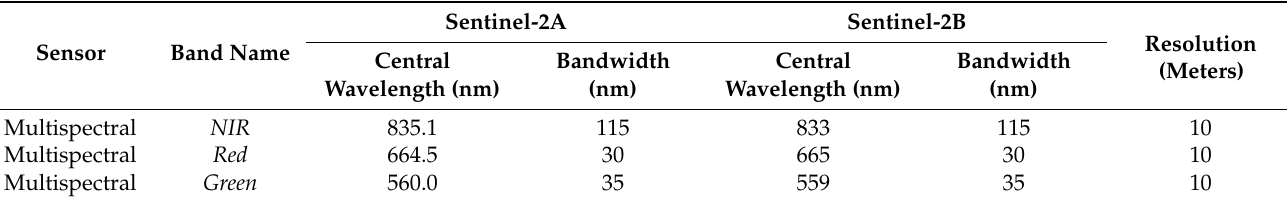
Table 1. Spectral bands available from Sentinel 2